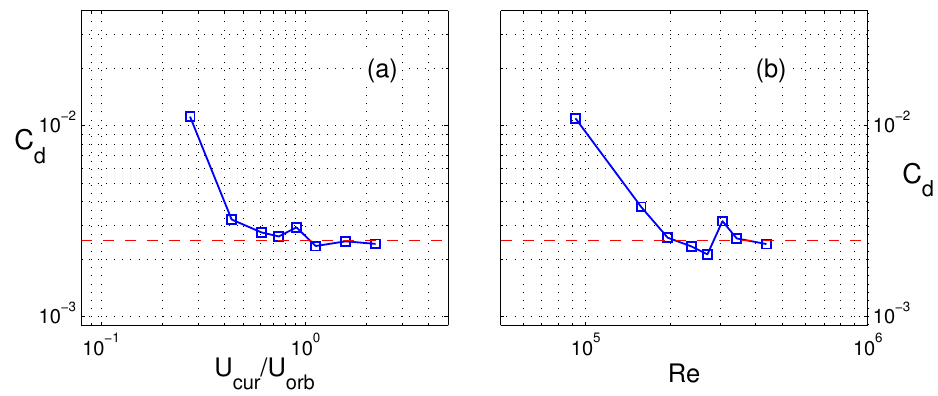
Figure 10. Variation of the bed drag coefficient ( C d ) as a function of ( a ) the ratio of current velocity to bottom wave orbital velocity; and ( b ) Reynolds number ( Re ). The red dashed lines indicate the canonical value of the bed drag coefficient, C d =